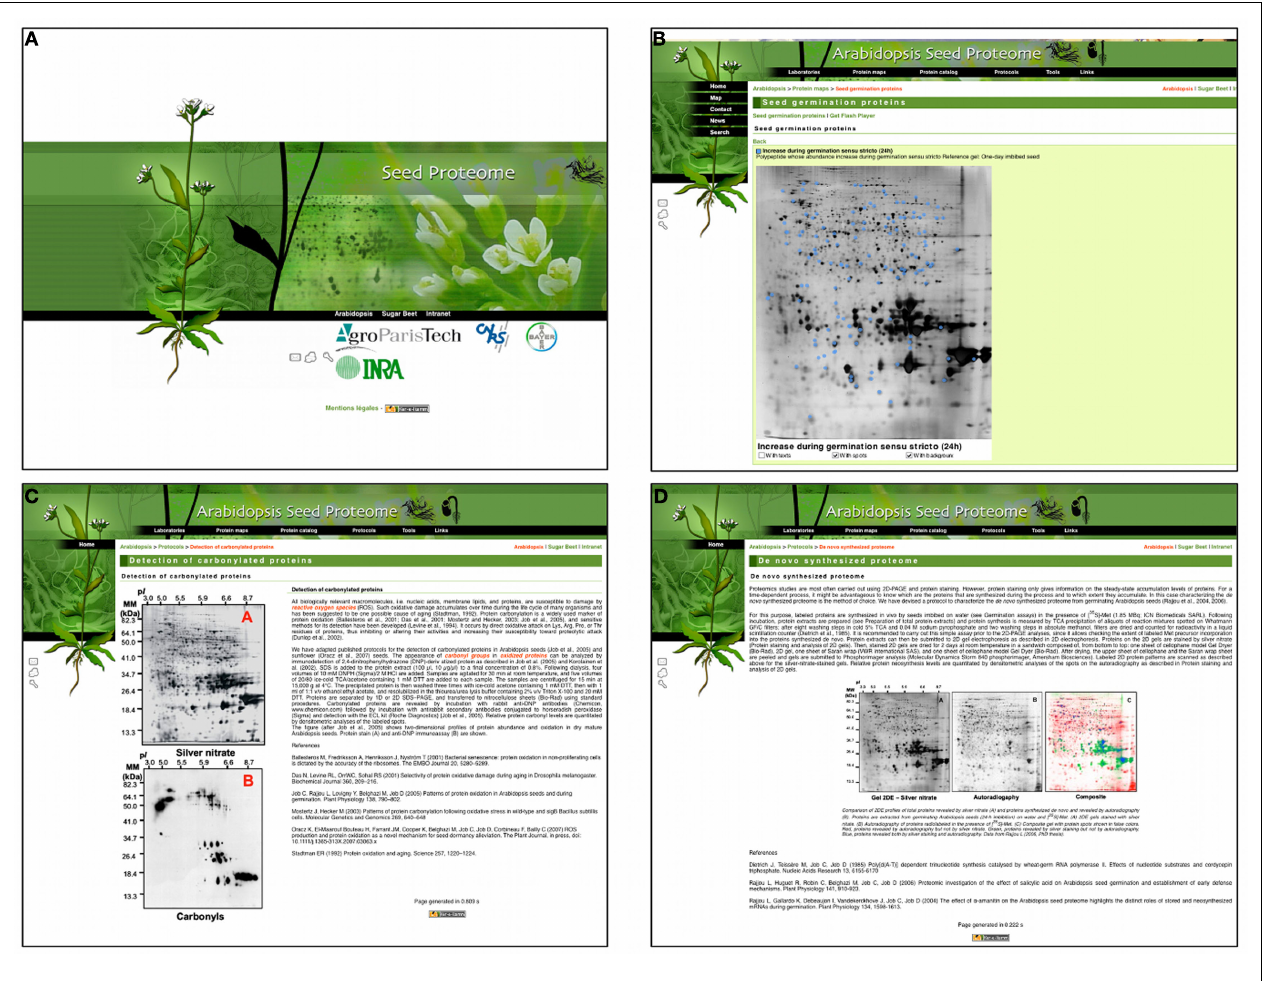
FIGURE 1 | Screenshots of theArabidopsis seed proteome web portal. Homepage (A) , 2D map of protein spots that increase during seed